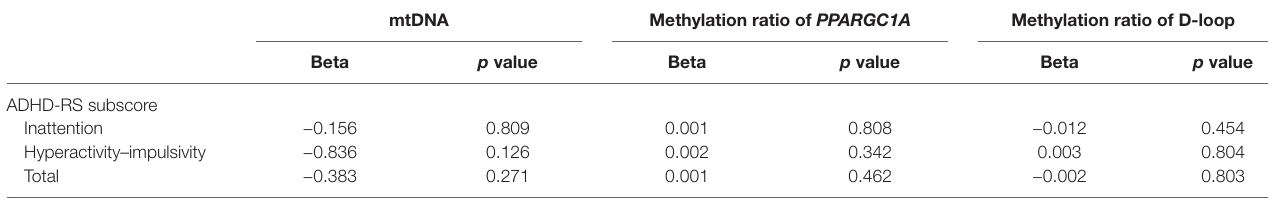
TABLE 2 | Correlation between mtDNA copy number, methylation ratio of PPARGC1A and D-loop region with ADHD-RS subscores in ADHD patients. mtDNA Methylation ratio of